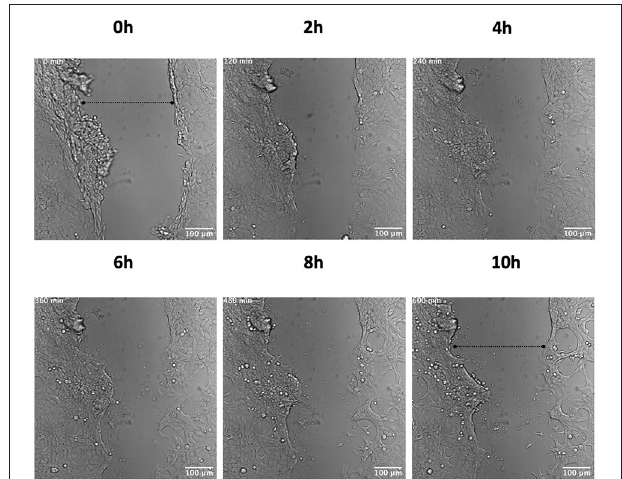
FIGURE 3 | AP53R + S − does not induce retraction of a keratinocyte wound in the absence of hPg. Scratch wounds were produced as in Figure 1 . The cells were then incubated with AP53R + S − at MOI 5 prior to live imaging. Images were obtained every 10min for 10h for the duration of the imaging experiment. Time-lapsed images of the experiment are shown here (see Supplementary Video 3 ). Dashed lines show the approximate width of wound at the start and end of the experiment.